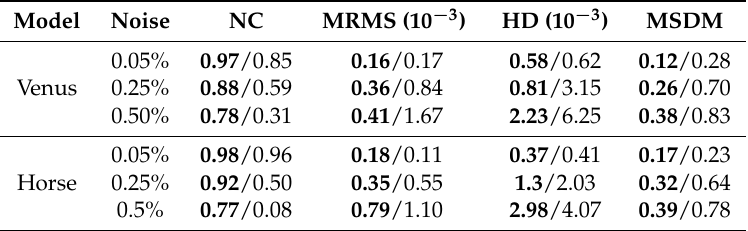
Table 18. Quality and robustness comparison with Wang et al.’s scheme [3] against noise addition measured in terms of MRMS, HD, MSDM, and NC.